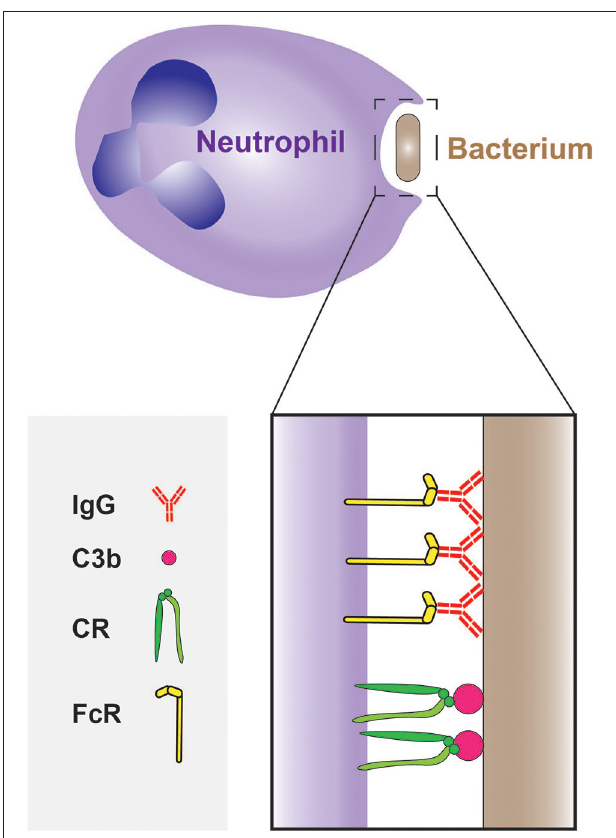
FIGURE 3 | Phagocytosis of bacteria by neutrophils. The phagocytosis of bacteria is often mediated by opsonisation of their surface with IgG and C3b molecules, which are recognized by Fc γ receptors (Fc γ Rs) and complement receptors (CRs),